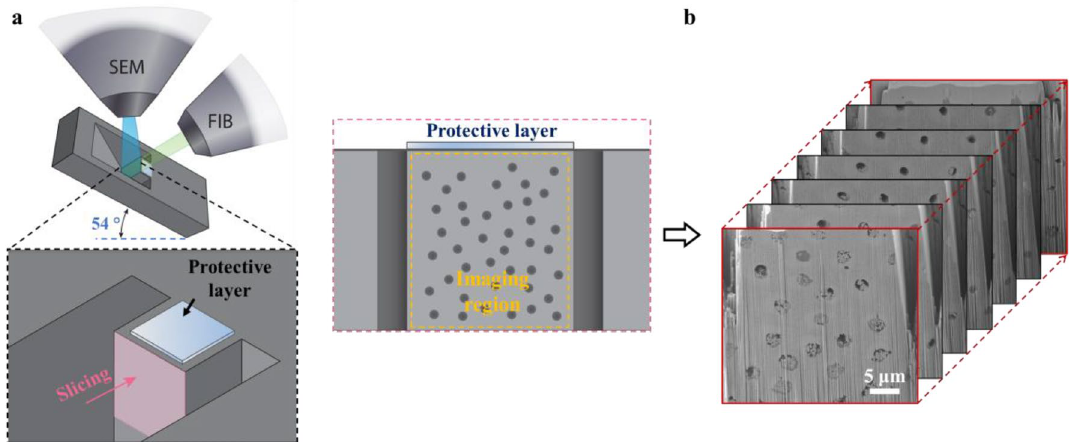
Figure 3. 3-D characterization of dentin specimen process using FIB-SEM tomography. ( a ) The schematic of the specimen setup in the FIB-SEM chamber for data acquisition. The pink arrow indicates FIB slicing by the transverse section. The cross-sectional image shows the region of interest for FIB milling and SEM recording. ( b ) 2-D image stacking obtained at different depths along the length direction of the